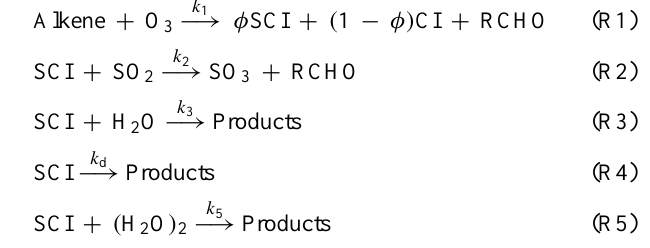
Scheme 2. Mechanism of formation of the nine possible Criegee intermediates (CIs) from isoprene